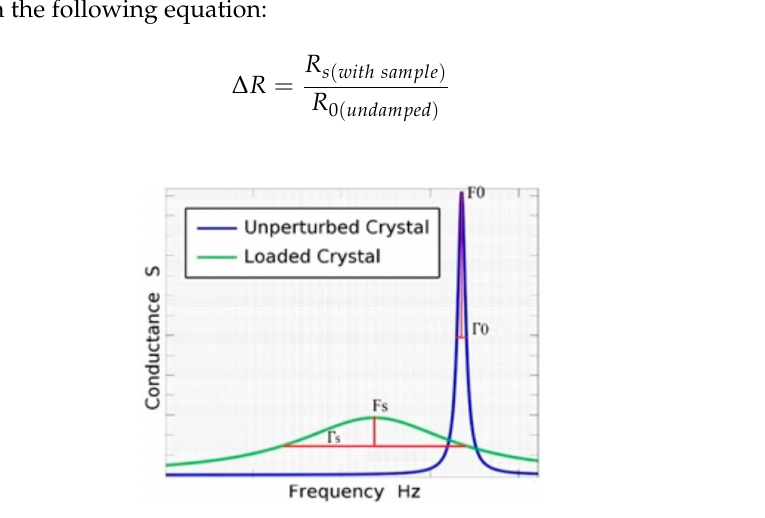
Figure 1. Change in the morphology of the conductance curve for bare crystal and in contact with a liquid sample.